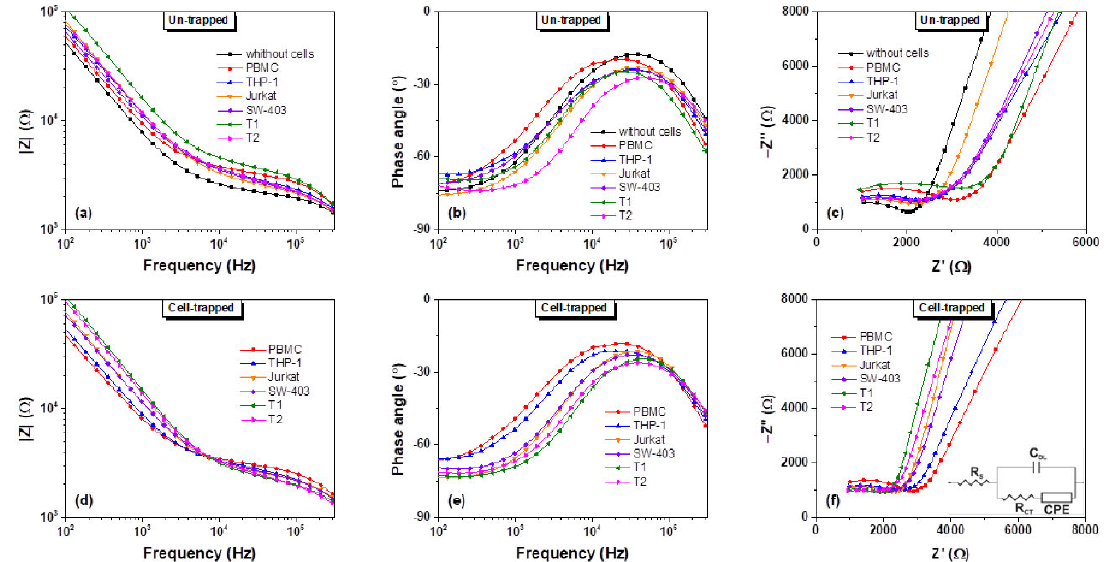
Figure 3. Electrical impedance spectroscopy responses (amplitude Z ( a , d ), phase angle ( b , e ), and Nyquist plots ( c , f )) of different cell types suspended in buffered sucrose solution, before and after cells